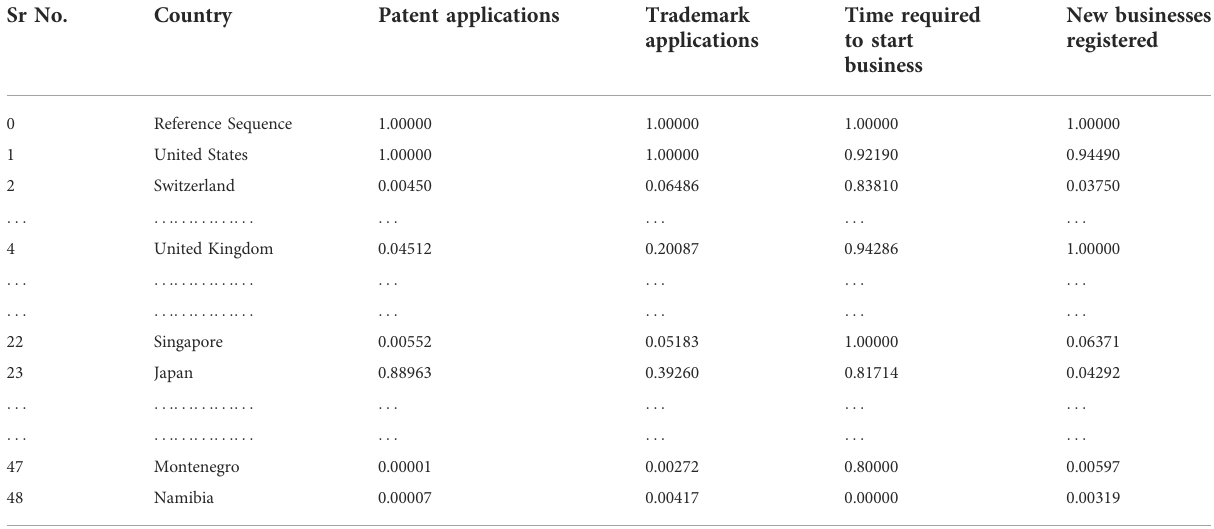
TABLE 4 Normalized comparable sequences.